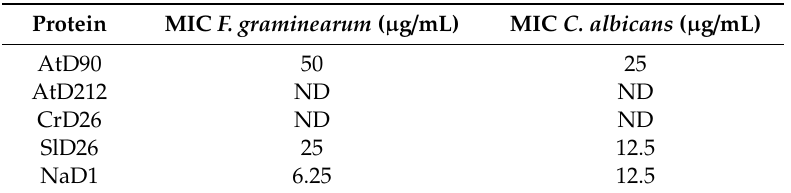
Table 3. Antifungal activity of